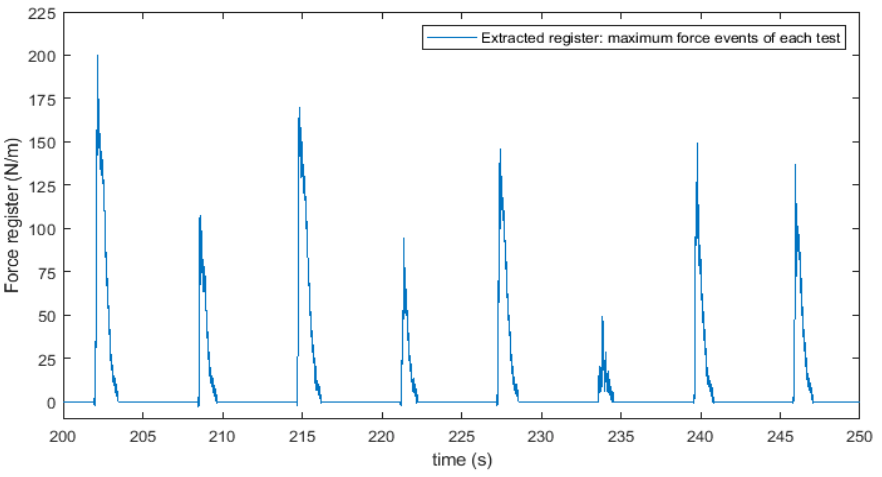
Figure 9. Extracted register made by grouping the maximum force events of each test (horizontal